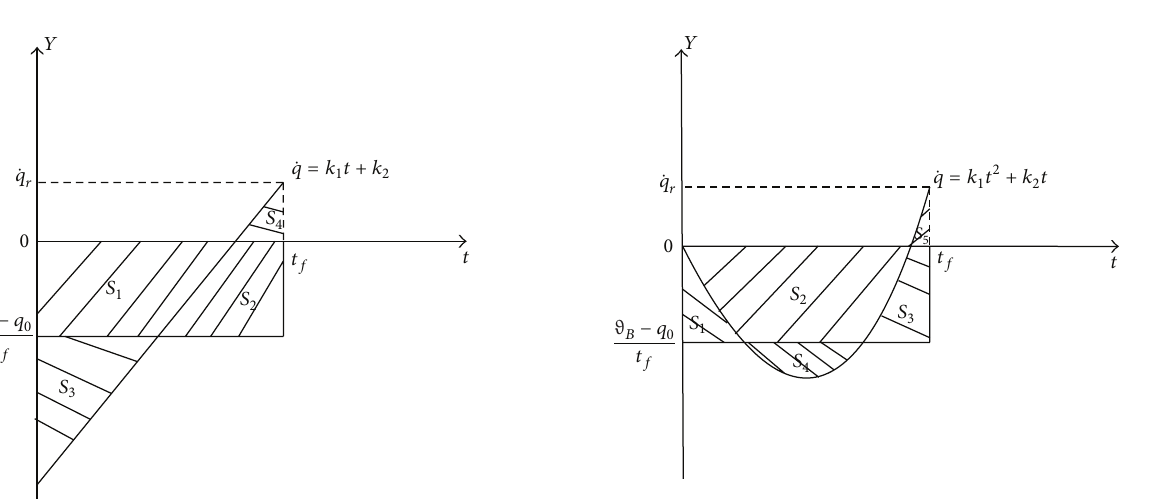
Figure 10: LOS angle rate equation designed by the second-order